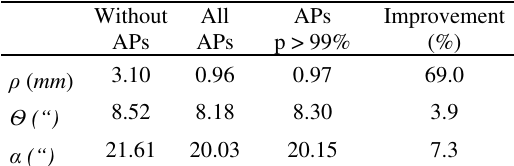
Table 2. A posteriori accuracies achieved for the observables based on two parameterizations. Improvement ratios between first and second columns (Adjustment